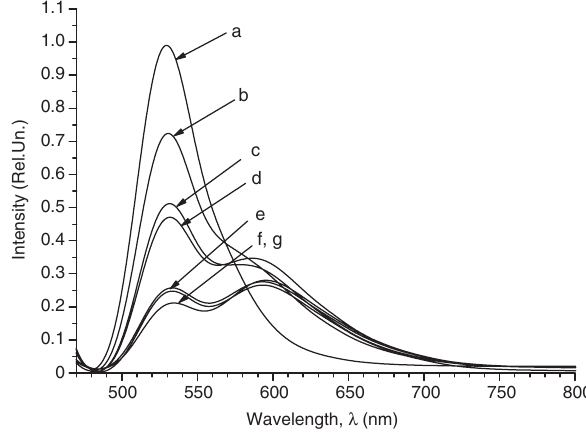
Figure 21 Heating effect on DNA solution located in a hermetic test tube in thermostat at various temperatures t=323, 333, 343, 353 and 363K. (a) DNA-AO, (b) DNA-AO-EB, (c) DNA-AO-EB 323K, (d) DNA-AO-EB 333K, (e) DNA-AO-EB 343K, (f) DNA-AO-EB 353K, (g) DNA-AO-EB 363K . [DNA] – 2.8 × 10 -4 mol/l (P), [AO] – 0.14 × 10 -4 mol/l, [EB] – 0.14 × 10 -4 mol/l, [NaNO ] – 10 -2 mol/l. 3